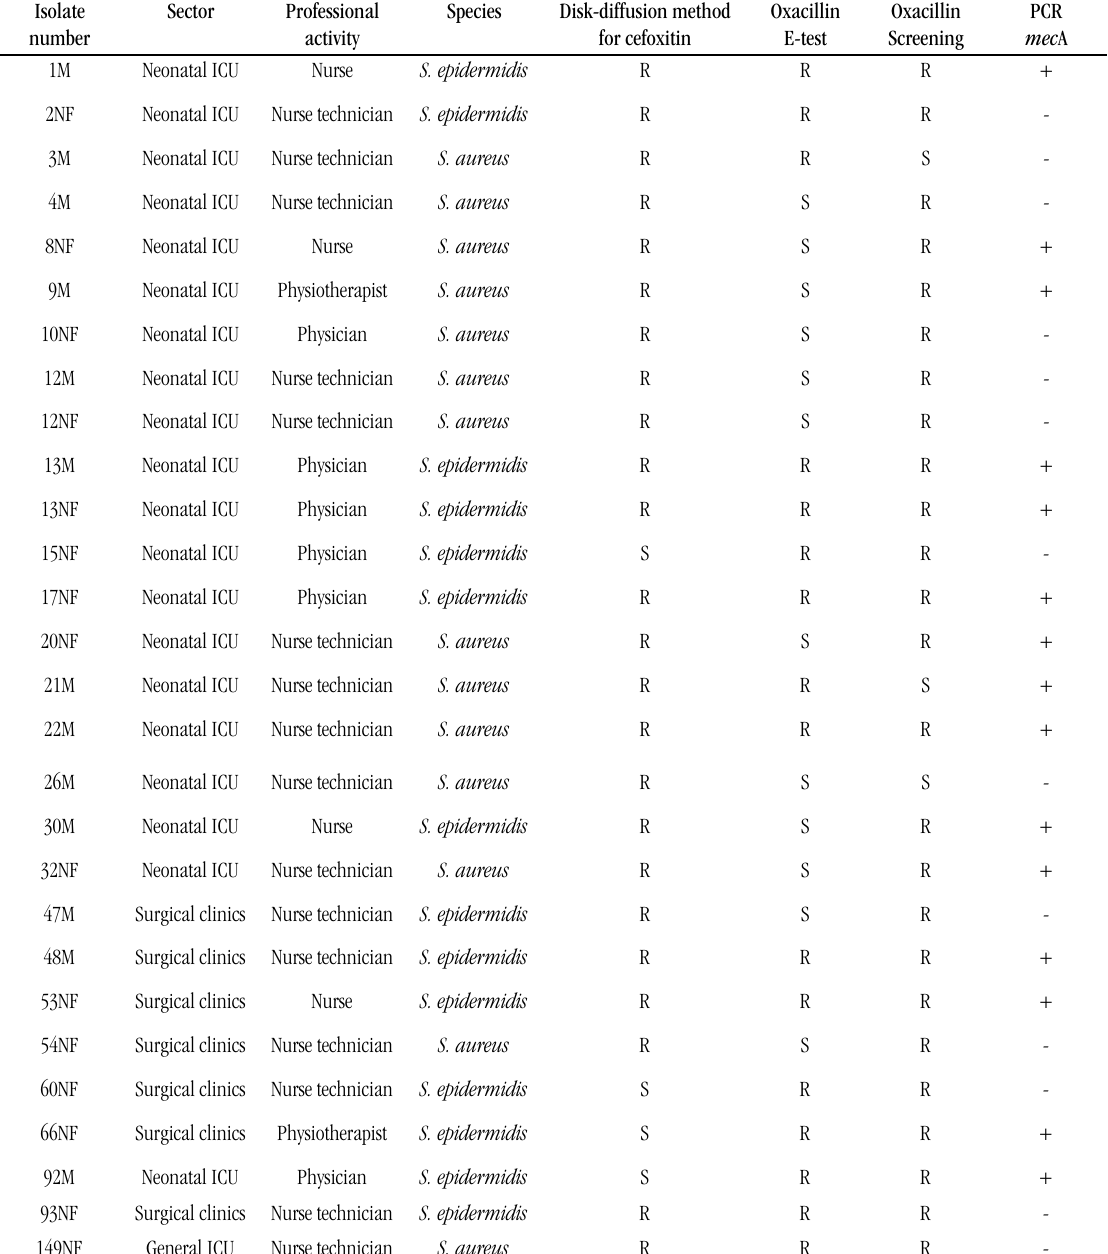
tABLE 1 – Phenotypic test results and mec A gene detection